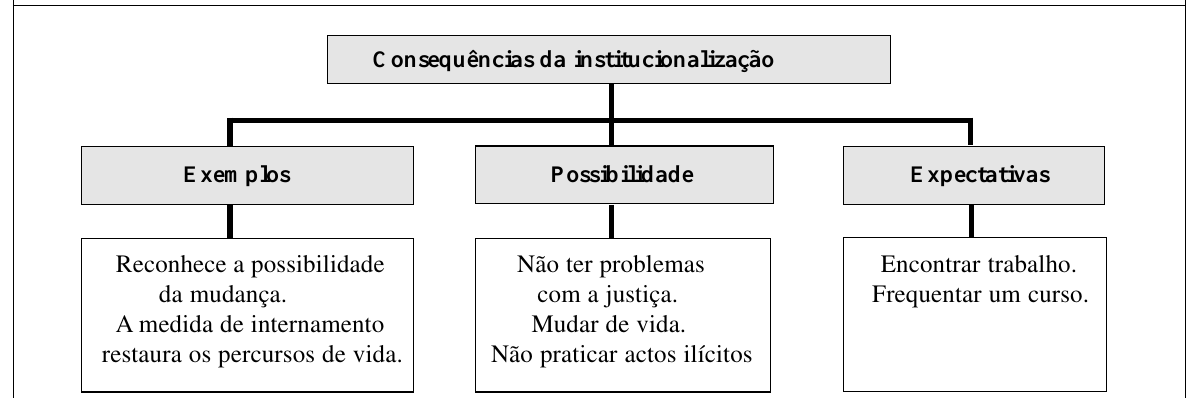
Figura 3 . Excerto de entrevista e respectivo mapa conceptual de T.G.E. Categoria: medida de internamento. Subcategoria: consequências do